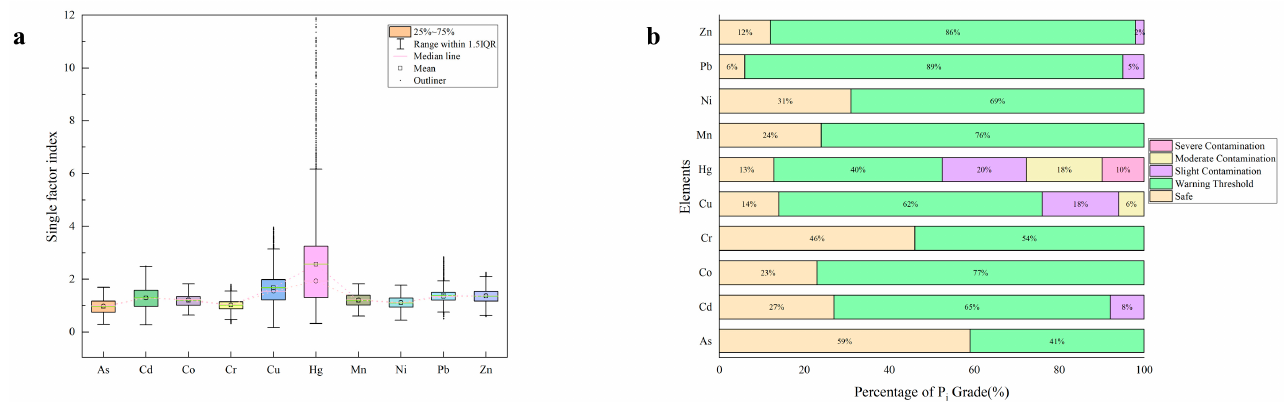
Figure 6. ( a ) Single factor index (P i ) of HMs in Farmland soil and ( b ) the percentage of P i grade (%).